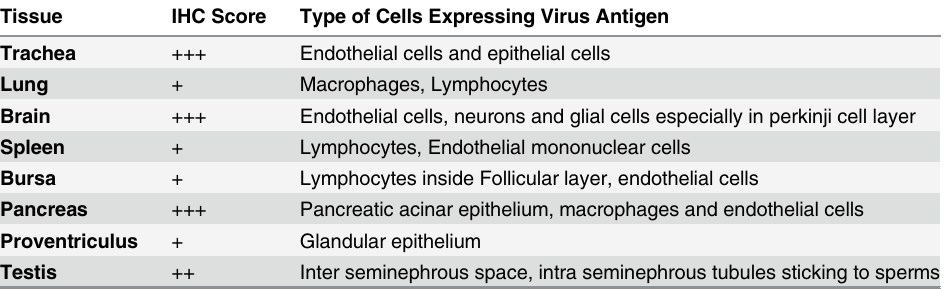
Inter seminephrous space, intra seminephrous tubules sticking to sperms IHC scoring system: (-) no viral antigen detected; (+) sporadic; (++) common; (+++) widespread.